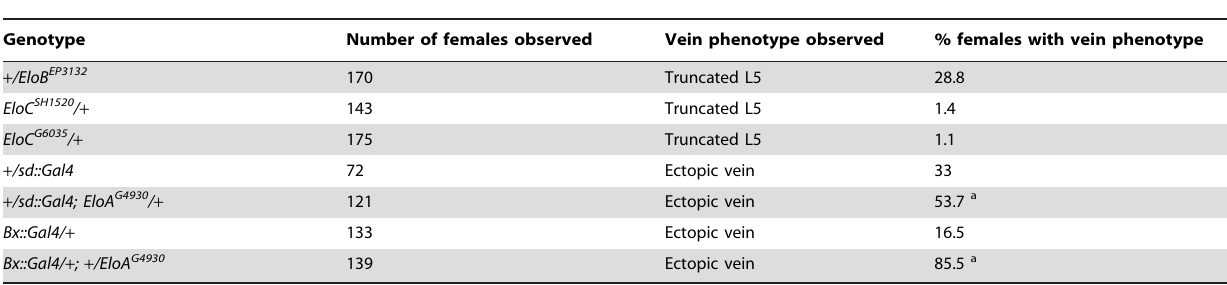
Table 1. EloA and EloC deregulation induce wing vein defects.